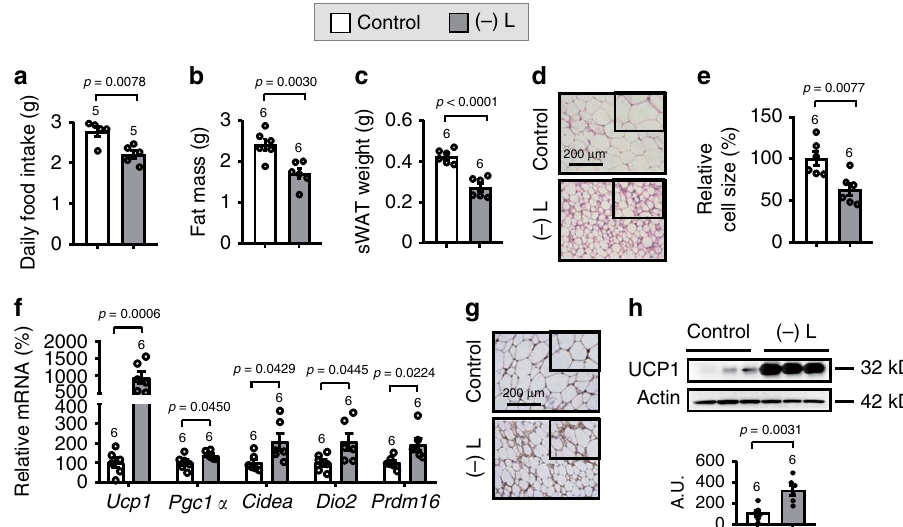
Fig. 1 Leucine deprivation induces WAT browning. a Daily food intake. b Fat mass by NMR. c Subcutaneous WAT (sWAT) weight. d Representative images of hematoxylin and eosin (H&E) staining of sWAT. e sWAT cell size quanti fi ed by Image J analysis of H&E images. f Gene expression of Ucp1, Pgc1a, Cidea, Dio2 , and Prdm16 in sWAT by RT-PCR. g Representative images of immunohistochemistry (IHC) staining of UCP1 in sWAT. h UCP1 protein in sWAT by western blotting (top) and quanti fi ed by densitometric analysis (bottom); A.U.: arbitrary units. Studies were conducted using 14- to 15-week-old male wild-type mice fed a control (Control) or leucine-de fi cient [(-) L] diet for 3 days. Data are expressed as the mean ± SEM ( n represents number of samples and are indicated above the bar graph), with individual data points. Data were analyzed by two-tailed unpaired Student ’ s t test. Source data are provided as a Source data fi